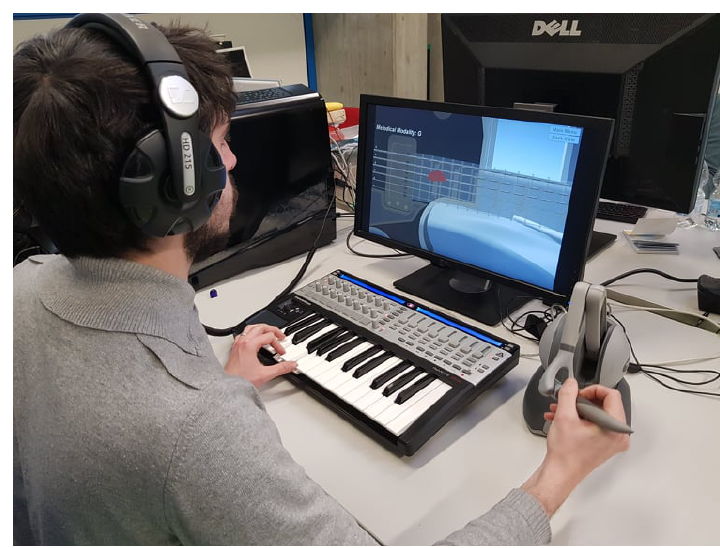
Figure 1. The Keytar interface, with a robotic arm for plucking and a keyboard for selecting the notes of the virtual